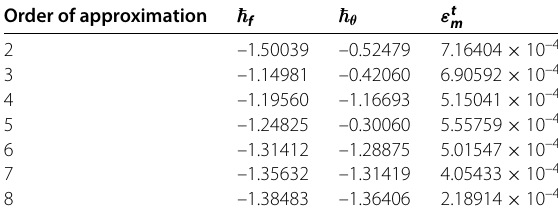
Table 1 Optimal value of convergence control parameters for different orders of approximations